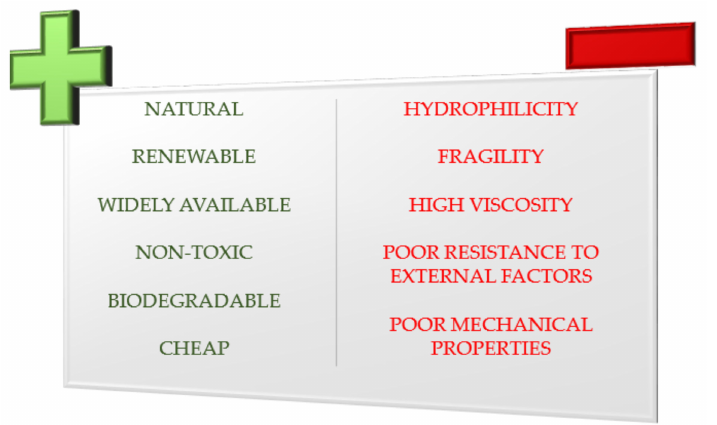
Figure 2. Advantages and disadvantages of starch as a potential packaging